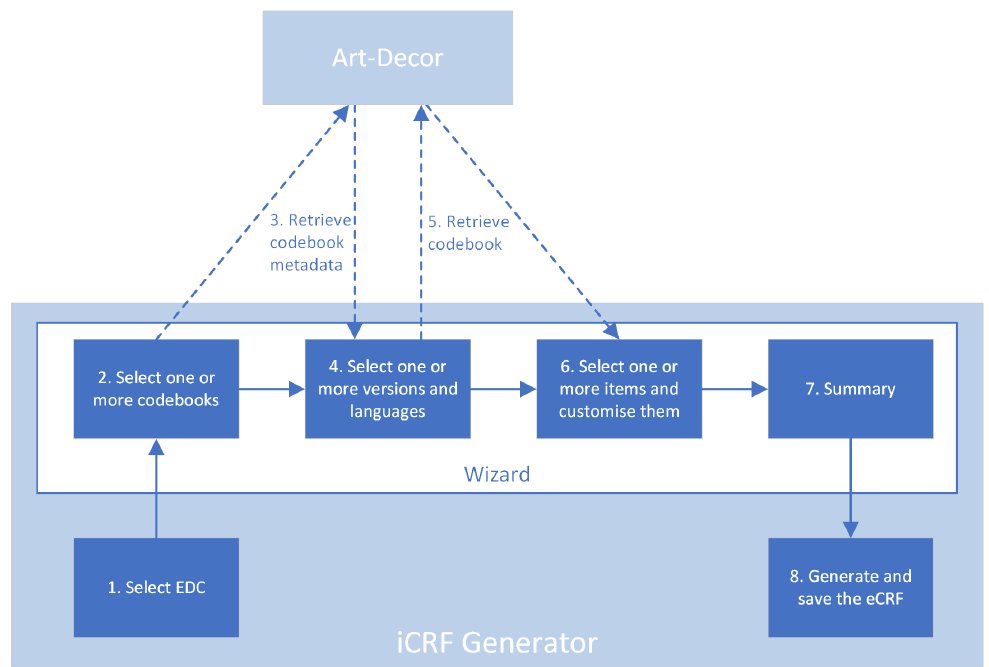
Figure 1. Flowchart showing steps involved in using the iCRF Generator. Dotted lines are calls made by the program to ART-DECOR’s REST